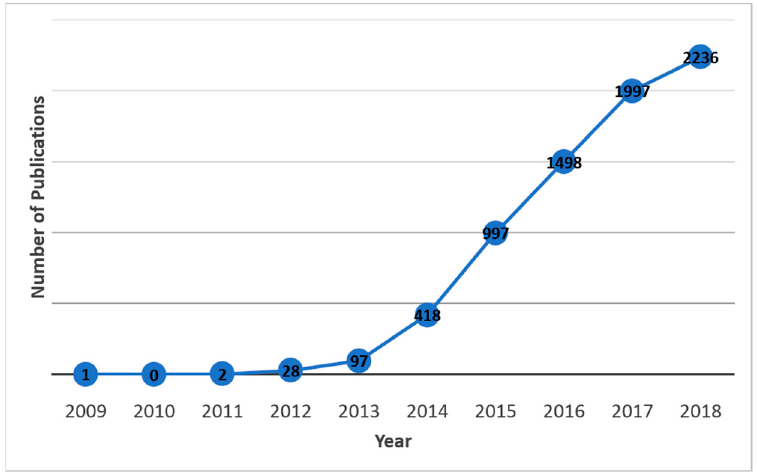
Figure 3. Journal article publication of big data research in the Scopus database per year between